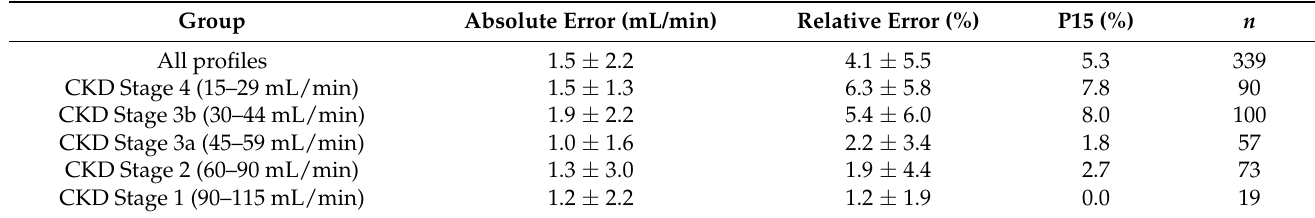
Table 2. Limited sampling strategy performance on determining mGFR for the simulated profiles, presented as the absolute and relative error from the simulated “true” GFR. Data are presented as mean ± standard